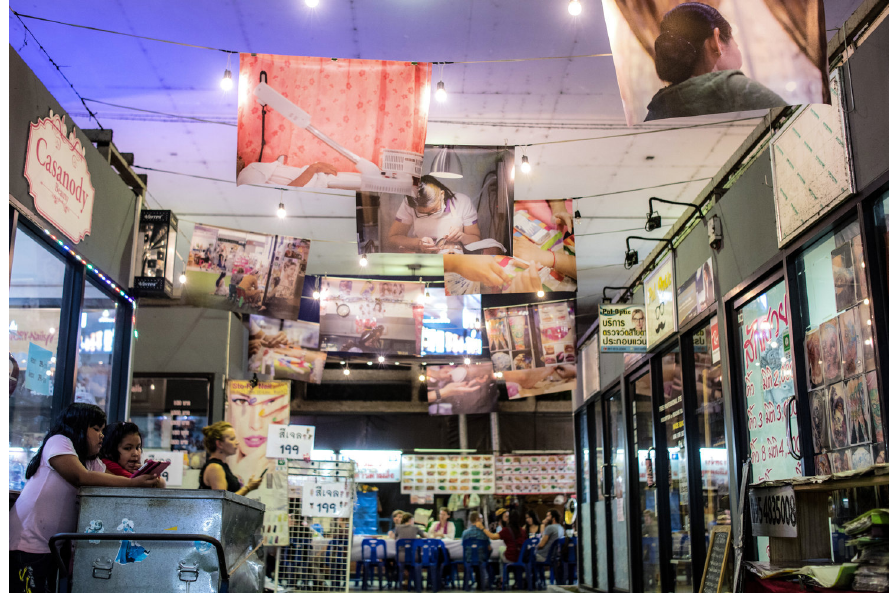
Figure 10. Bangrak Beauty by Sareena Sattapon, photos of workers and vendors in Bangrak Bazaar’s beauty zone (September 2018). Photo courtesy of